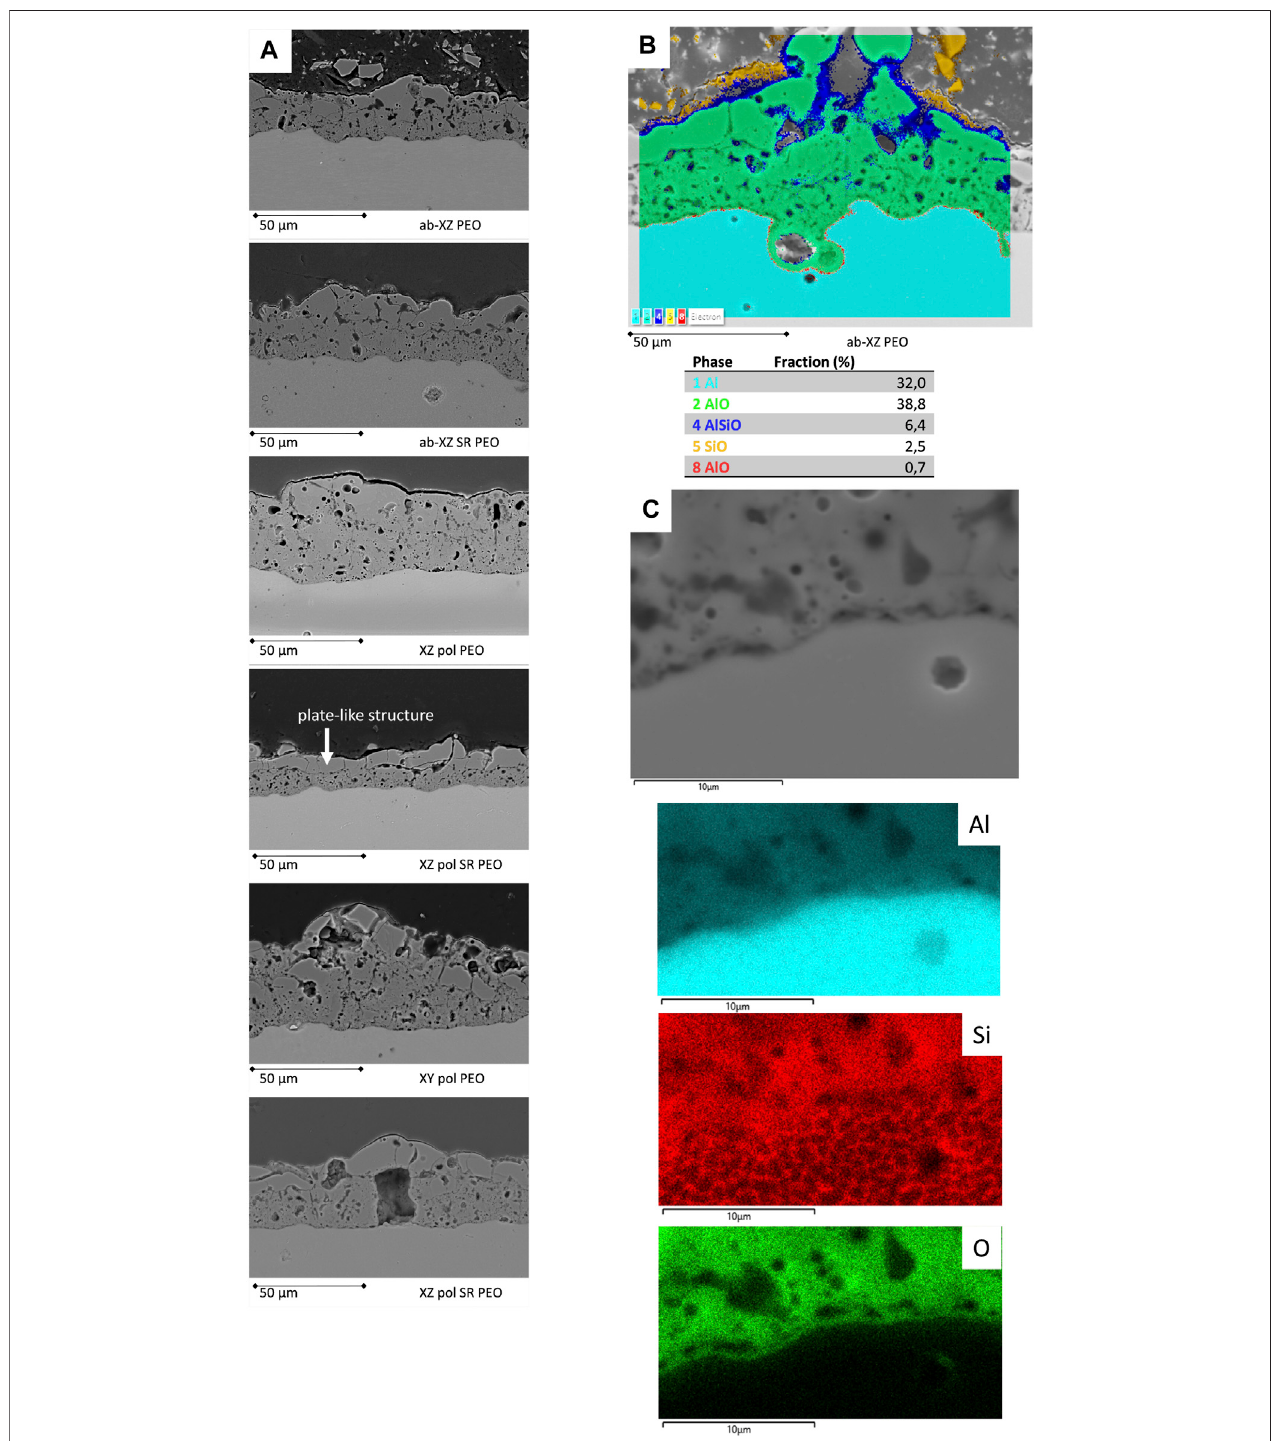
FIGURE 4 | Cross-sectional views of the PEO-coated surfaces; (A) BSE-SEM micrographs of the PEO-coated printed surfaces; (B) PEO enclosed near-surface keyhole pore and its EDS phase analysis; (C) view of the interface of the PEO coating accompanied by the EDS elemental mappings.